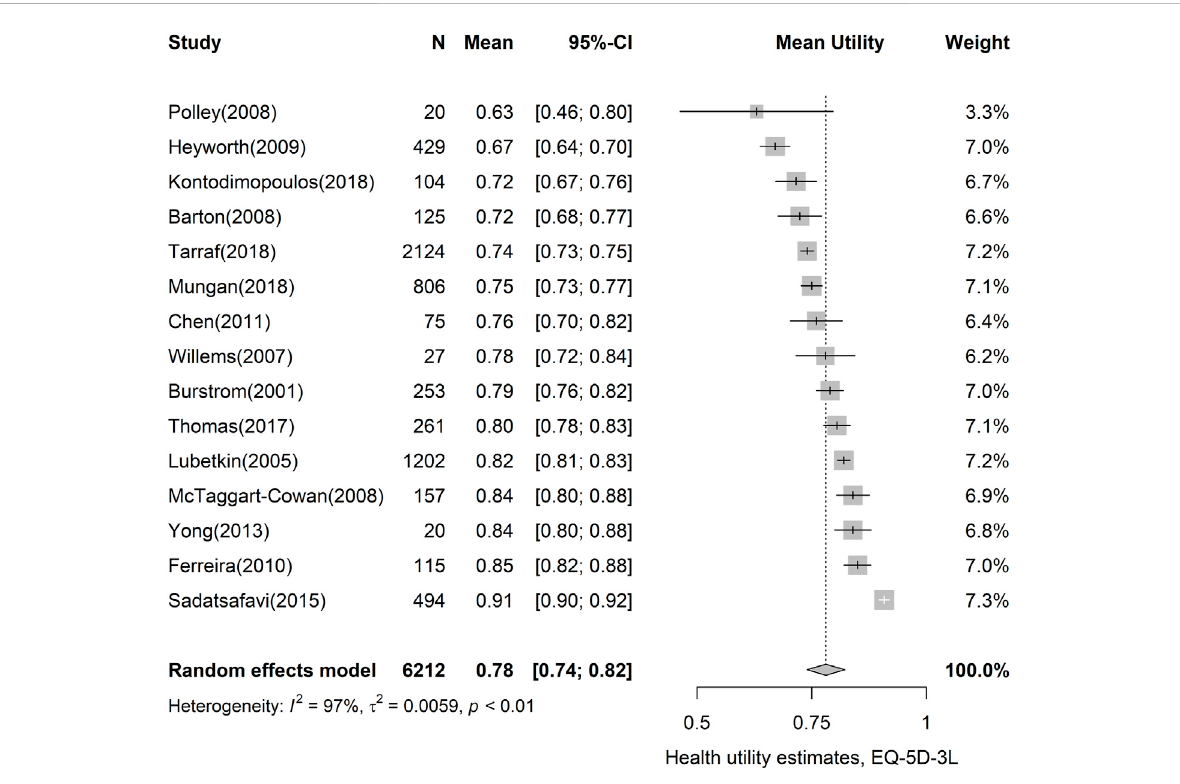
FIGURE 2 Forest plot of asthma utility, using the EQ-5D-3L instrument. CI, con fi dence interval; EQ-5D-3L, EQ-5D-3-level